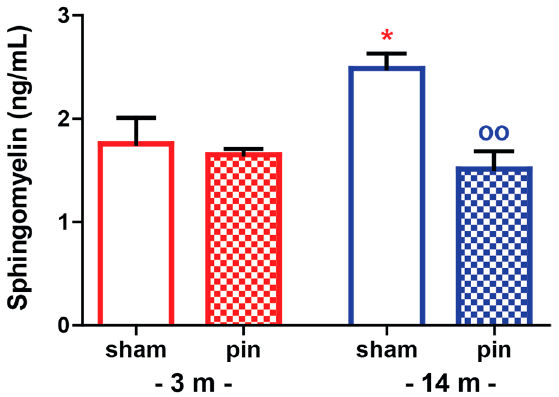
Figure 7. The effect of pin on sphingomyelin levels in the hippocampus of 3- and 14-month-old rats. Data are presented as mean ± S.E.M. * p = 0.032, 14-month sham compared to 3-month-old rats; oo p = 0.003, 14-month-old pin compared to matched sham group. 3-month-old rats—red; 14-month-old rats—blue; 18-month-old rats—green.